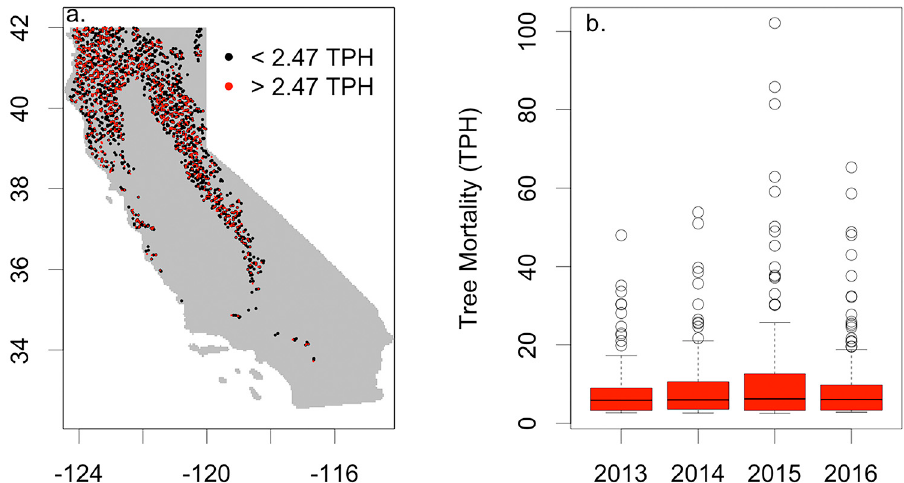
Figure 5. ( a ) Forest Inventory Analysis (FIA) plots with elevated tree mortality rates (red) denote the patchy nature of mortality within forested areas. ( b ) Maximum post drought tree mortality in elevated FIA plots peaked in 2015. Latitude and longitude are shown along the axes.